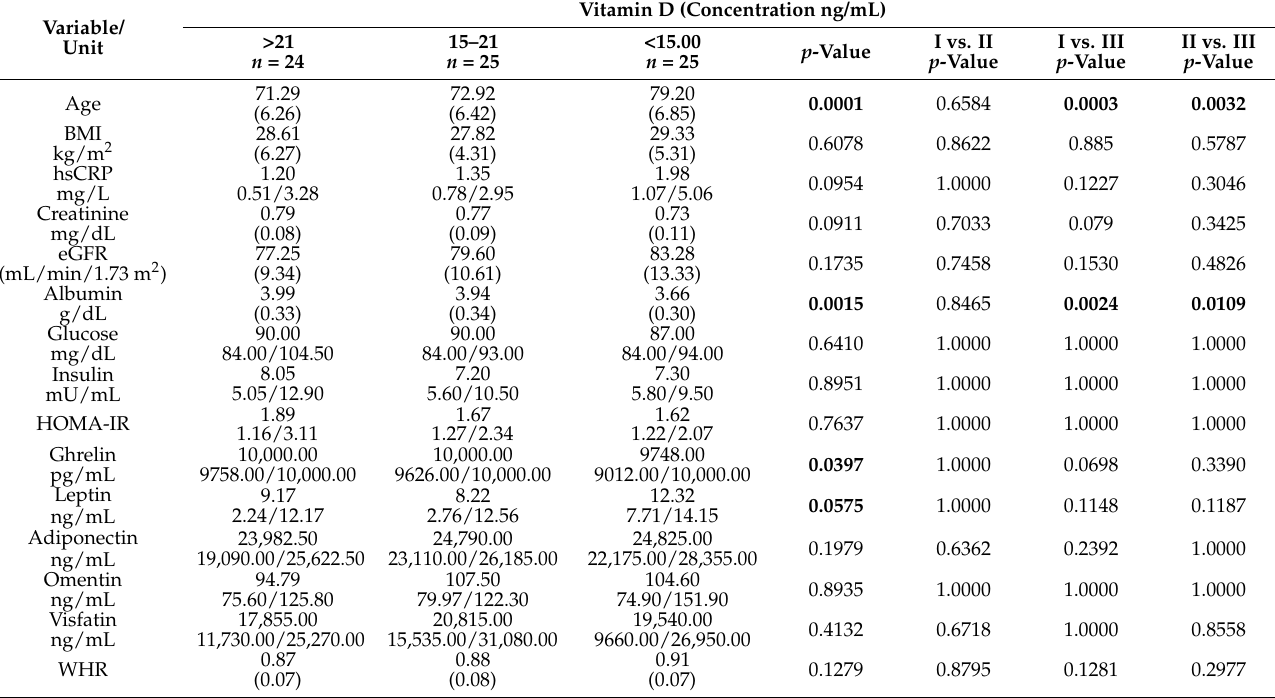
Table 4. Patients’ clinical characteristics according to vitamin D levels.